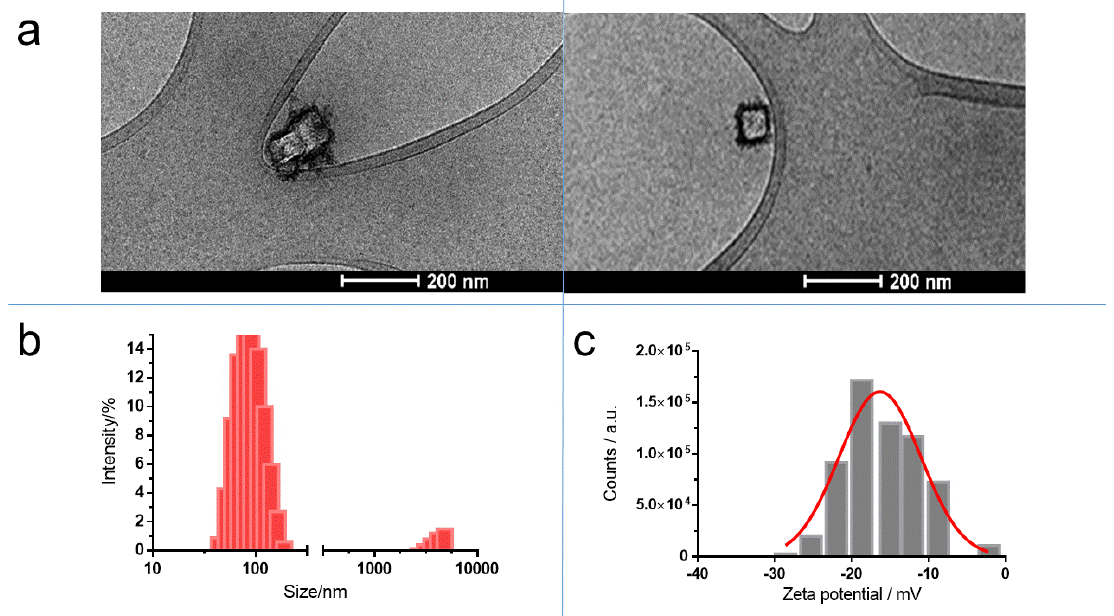
Figure 4. Characterization of PB nanoparticles trapped in lipid structure: ( a ) Cryo-TEM images; ( b ) size distribution determined by dynamic light scattering; and ( c ) ζ-potential distribution measured by Doppler electrophoresis.